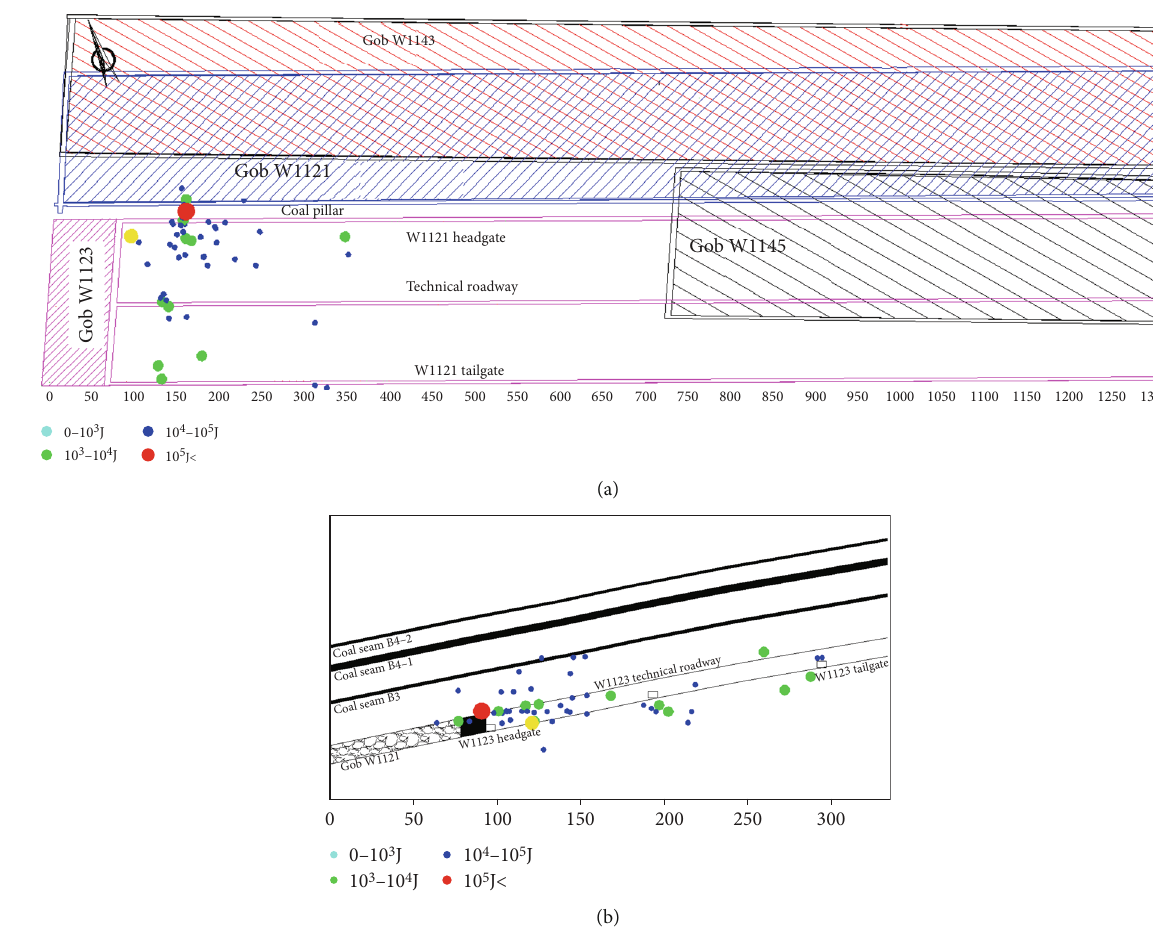
Figure 2: Microseismic event distribution. (a) Plane diagram. (b) Section